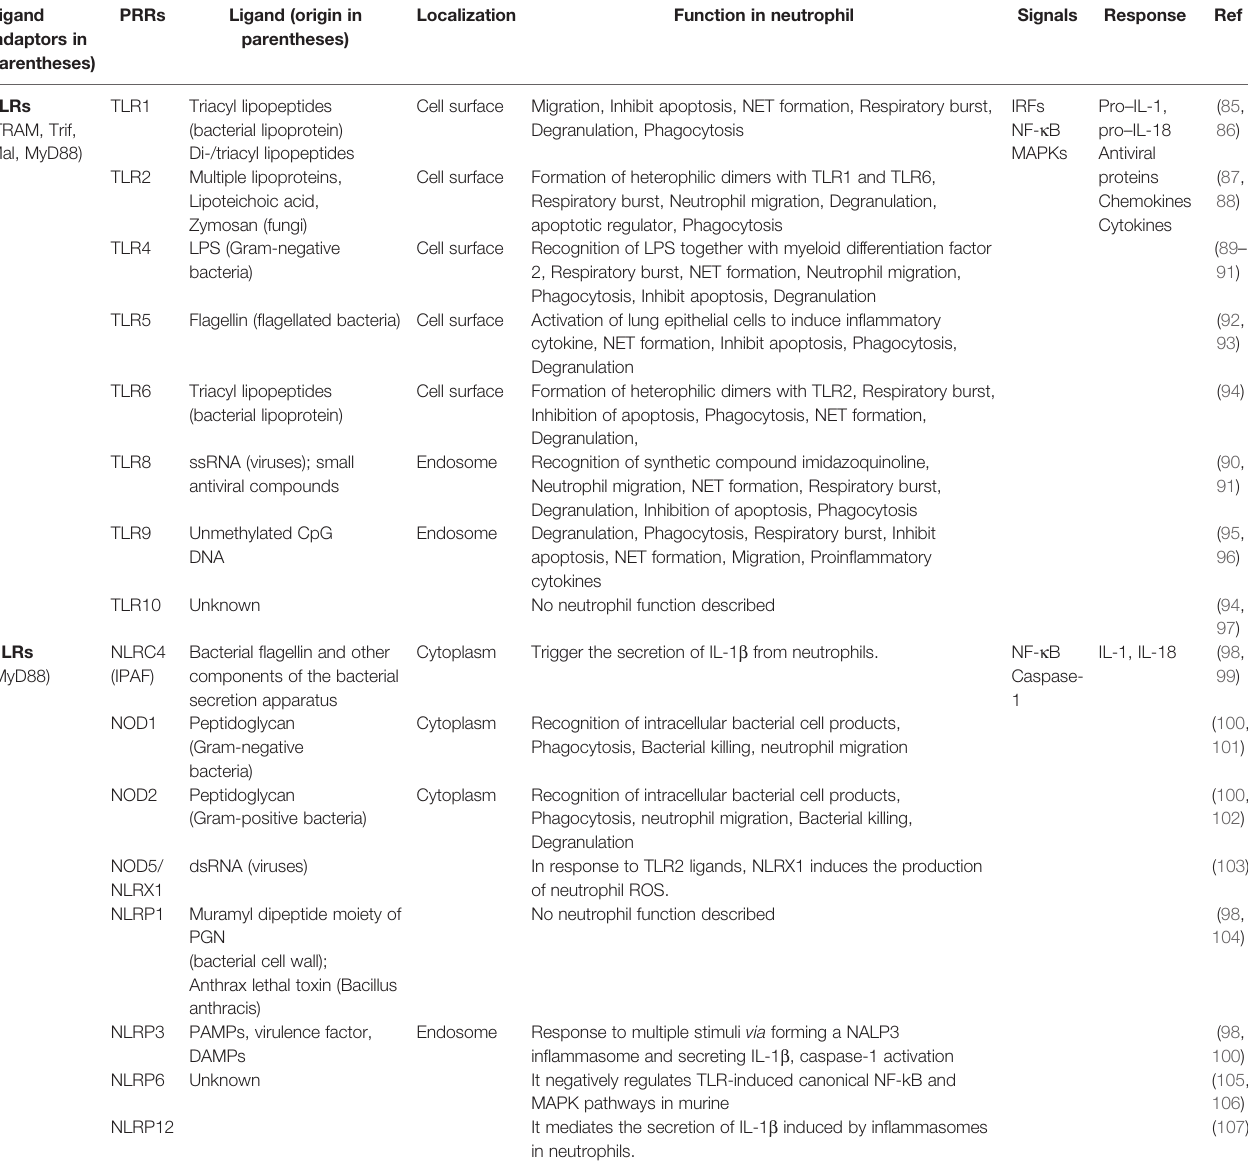
TABLE 1 | Summary of some pattern recognition receptors and their functions in innate